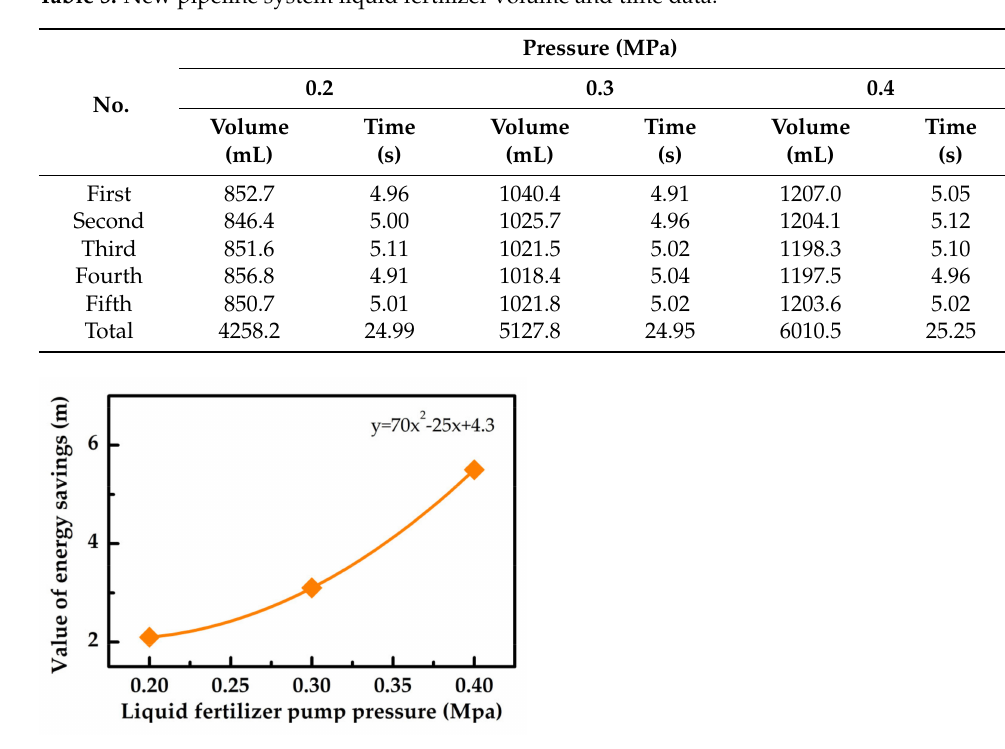
Table 5. New pipeline system liquid fertilizer volume and time data.